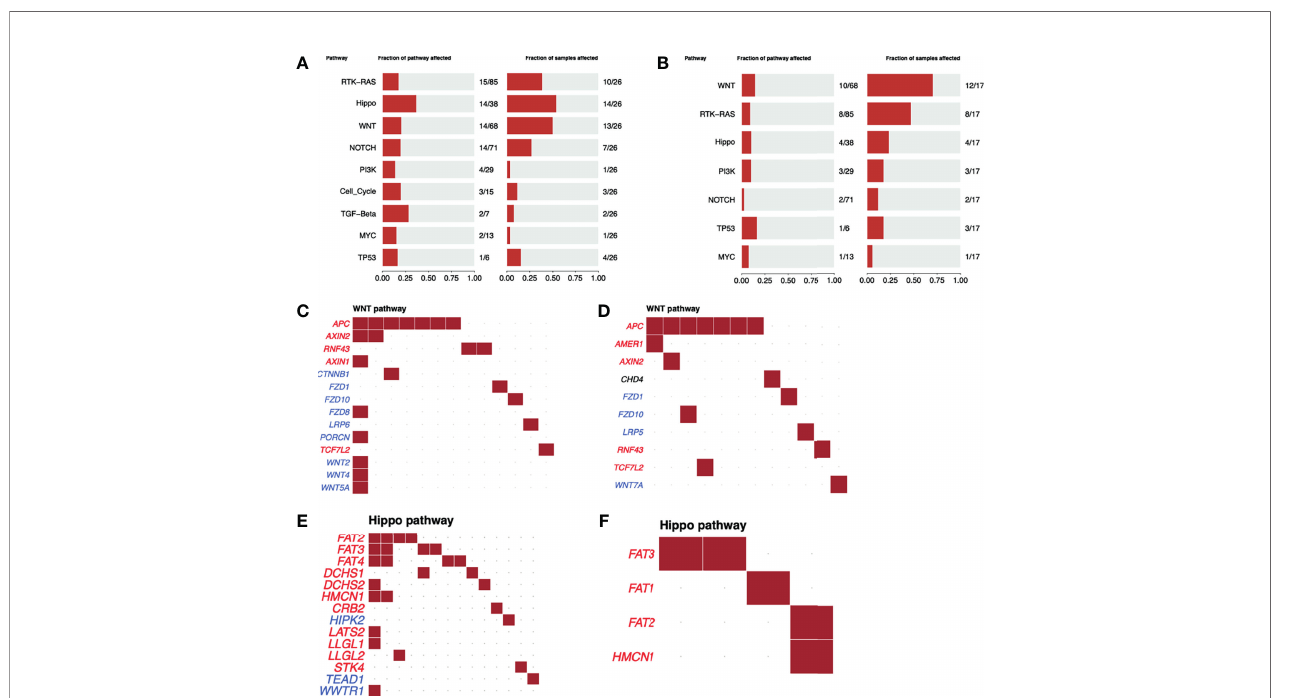
FIGURE 2 | Oncogenic pathway analysis in WES data from LARC. The most altered oncogenic pathways in LARC biopsies before neoadjuvant treatment in (A) NR and (B) R patients. Wnt- b catenin oncogenic pathway alterations in LARC biopsies before neoadjuvant treatment in (C) NR and (D) R patients. Tumor suppressor genes are represented in red and oncogenes in blue. Each square represents a sample with a mutation in the respective gene. Hippo oncogenic pathway alterations in LARC biopsies before neoadjuvant treatment in (E) NR and (F) R patients. Tumor suppressor genes are represented in red and oncogenes in blue. Each square represents a sample with a mutation in the respective